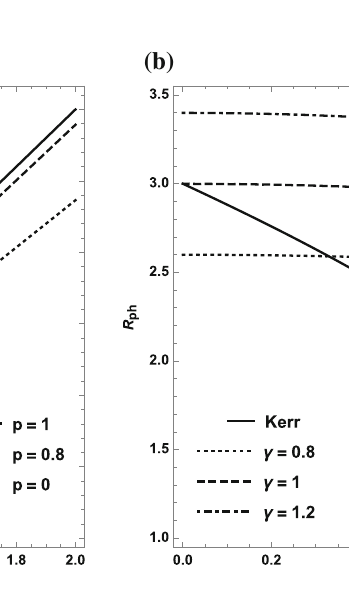
Fig. 5 The radial dependence of the effective potential V ef f ( r ) for photons in the equatorial plane of the stationary ZV space-time as com- pared to the effective potential for Schwarzschild. Left panel: V ef f ( r ) is plotted for p = 0 . 8 and various values of γ . Right panel: V ef f ( r ) is